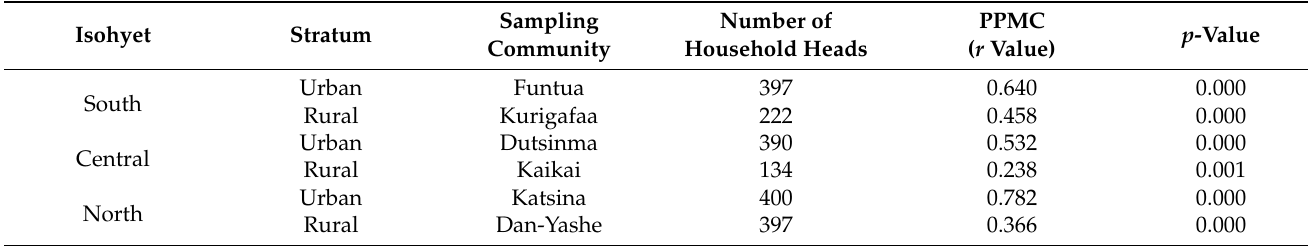
Table 4. Correlation between household head educational status and income.